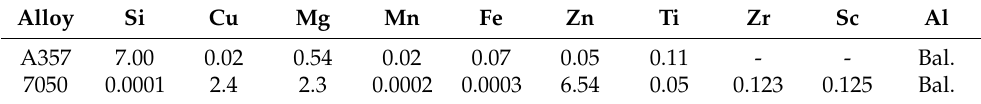
Table 1. Composition of the matrix alloys for composite casting (wt.%).